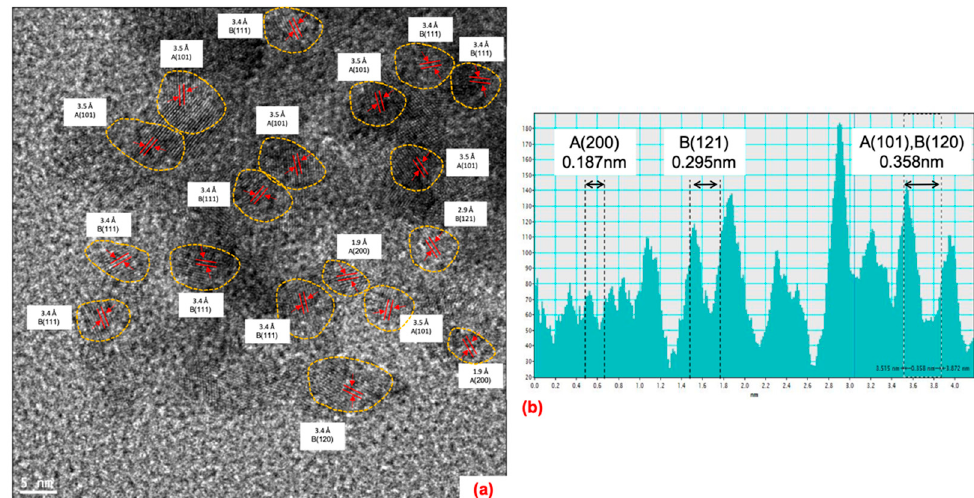
Figure 4. High-resolution TEM image of nanograined particles of the mixed-phase A / b nanoTiO 2 photocatalyst ( a ) and d-spacing lattice profile sampling ( b ) with evidence of phase co-existence within 2–3 nm space.